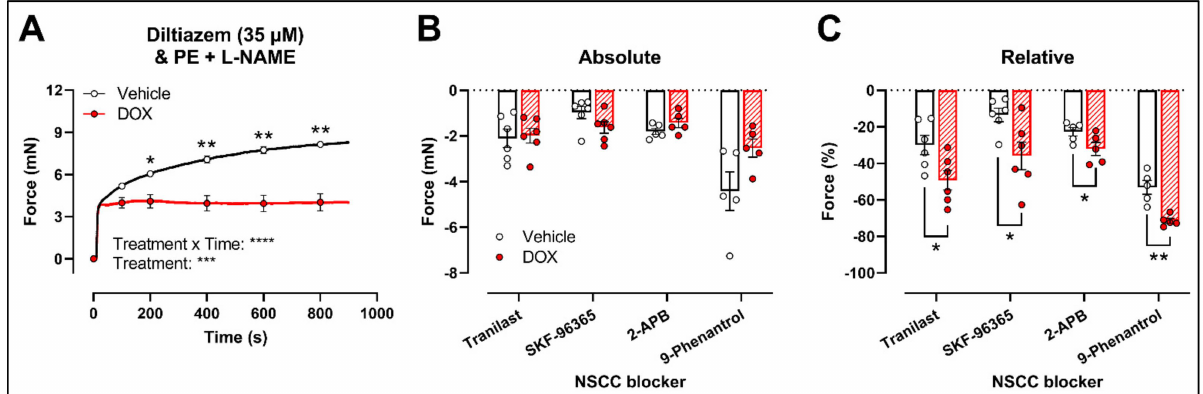
Figure 4. Evaluation of the involvement of members of the NSCC family in decreased PE-induced contraction in aortic segments after 16 h of ex vivo DOX treatment. ( A ) PE-induced contraction (2 µ M, with L-NAME) under diltiazem (35 µ M). ( B , C ) Absolute and relative decline in PE-induced contraction (with L-NAME and diltiazem) under different NSCC-blocker conditions. DOX decreased PE-induced contraction (with L-NAME) in the presence of diltiazem ( A ). In addition, the DOX-treated group did not display a significant change in VSMC contraction in absolute values ( B ) but showed a greater decline in VSMC contraction when expressed relative to its preceding contraction magnitude under tranilast (100 µ M), SKF-96365 (10 µ M), 2-APB (20 µ M) and 9-phenantrol (1 µ M) (C). For (A), repeated measures two-way ANOVA with Šid à k’s multiple comparisons test. For ( B , C ), unpaired t -test for each NSCC blocking condition. *, **, ***, **** p < 0.05, 0.01, 0.001, 0.0001; p > 0.05 in ( B ); n = 6 in each group.